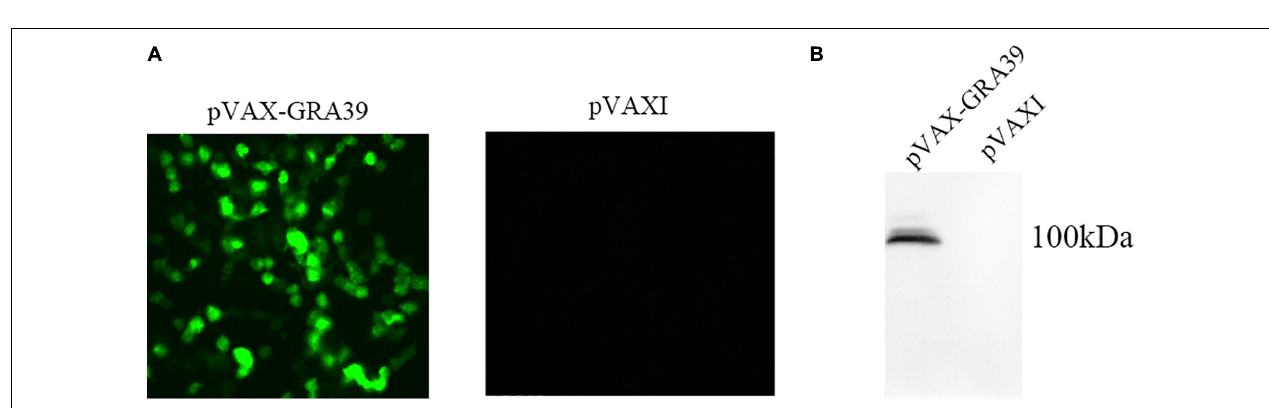
FIGURE 1 | Plot of the DNASTAR-predicted hydrophilicity, flexible regions, antigenic index, and surface probability plot of the linear-B cell epitopes of GRA39.